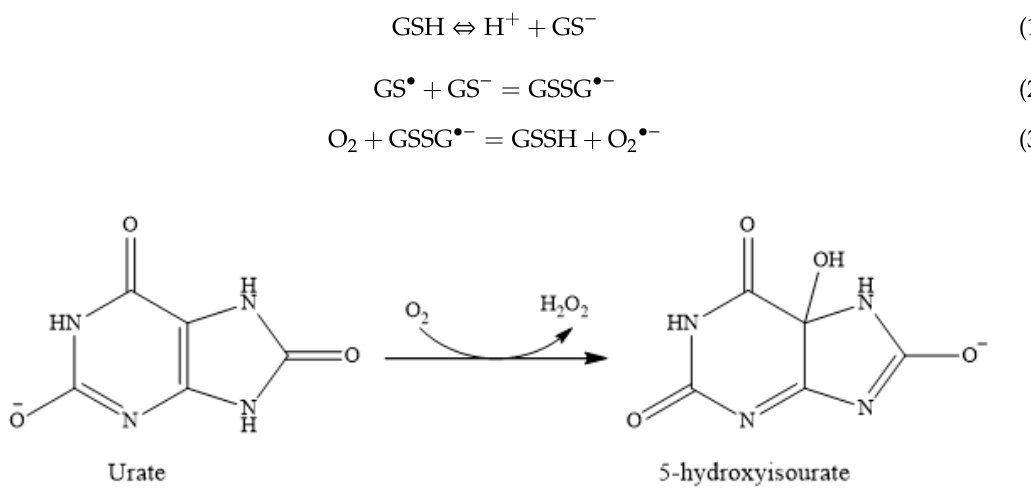
Figure 1. Urate can be oxidized by urate oxidase and forms 5-hydroxyisourate (HIU) initially [20].